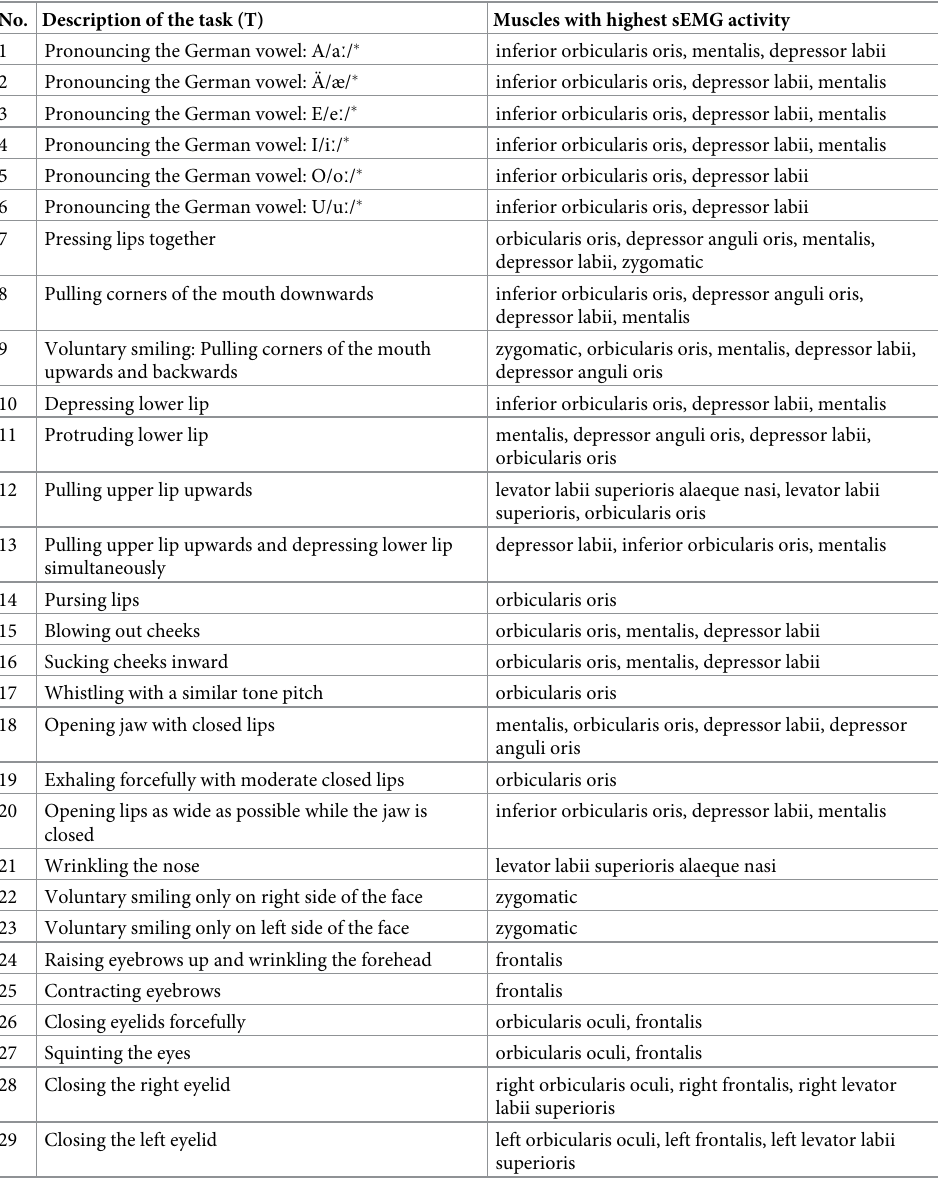
Table 1. Overview about the mimic tasks. No. Description of the task